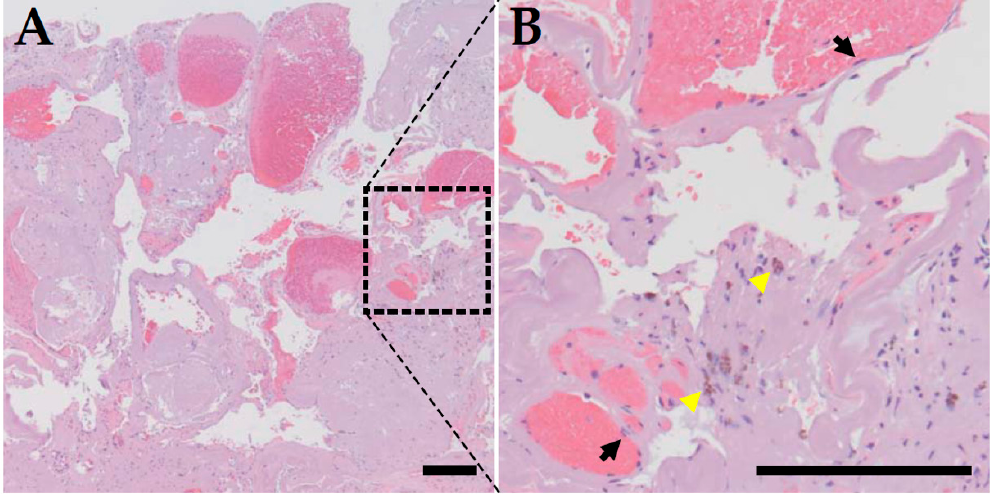
Figure 2. Histopathological presentation of CCM. ( A ) H&E staining of a surgically resected CCM lesion. It is composed of clusters of thin walled dilated microvessels with no supporting smooth muscle cells beneath the endothelial cell layer and no intervening brain parenchyma. Thrombi are present within the lumen of capillaries within the CCM lesion. ( B ) High power image of the boxed region of panel A. Black arrows point to individual endothelial cells lining the inner surface of dilated capillaries, and yellow arrowheads point to hemosiderin deposition adjacent to the capillaries, a sign of chronic bleeding. Bar = 200 μ m.